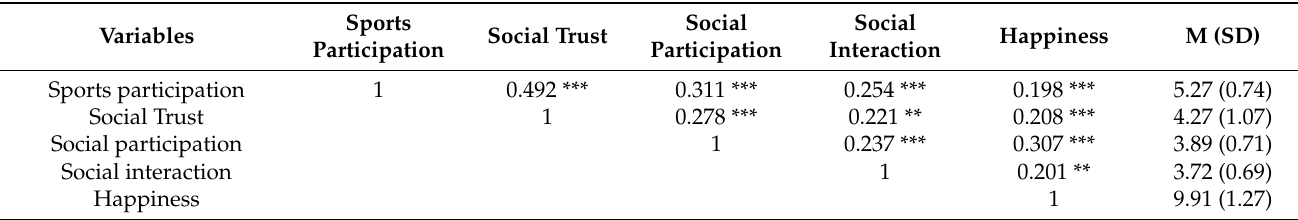
Table 4. Correlation coefficients of variables.